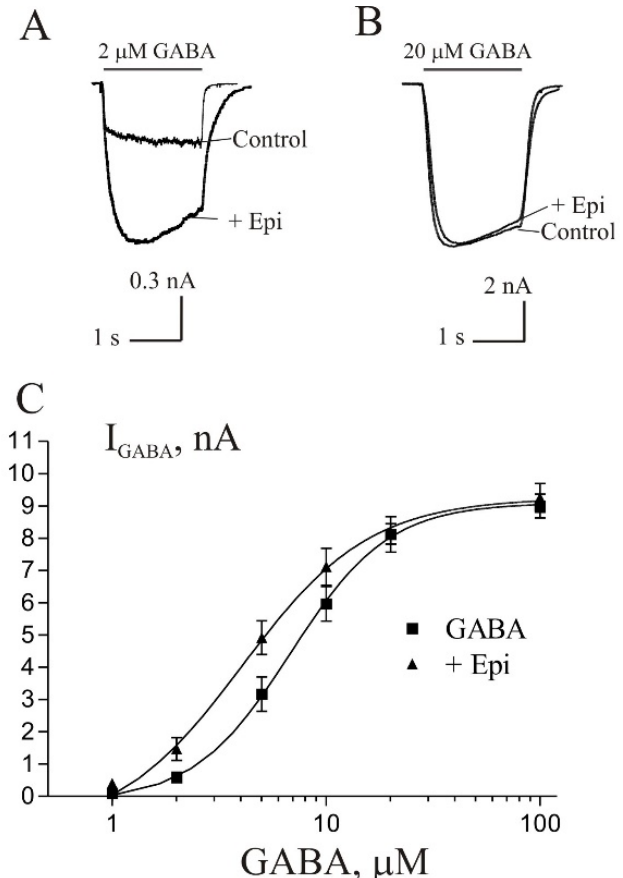
Figure 4. The degree of Epi effect depends on GABA concentration. ( A , B ) Representative traces of current induced by 2 µM GABA ( A ) and 20 µM GABA ( B ) in control and during co-application with 10 µM Epi. ( C ) Concentration–response curves for GABA obtained in control (squares) and in the presence of 10 µM Epi (triangles). Data points represent an average from six cells.